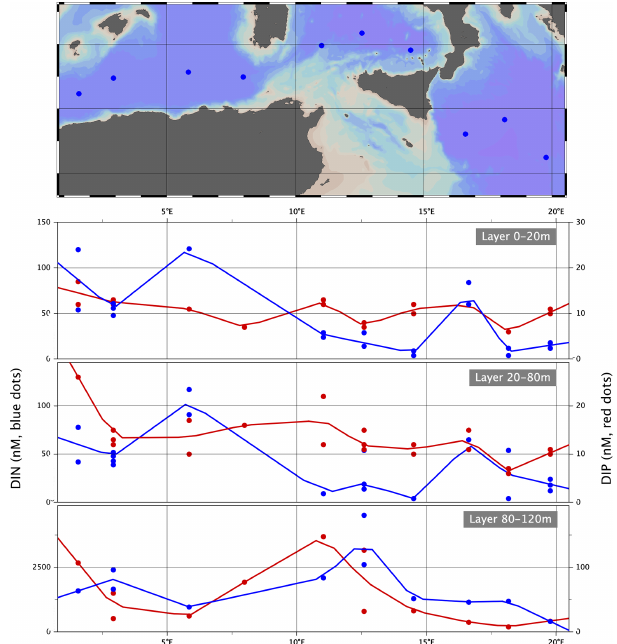
Figure 9. Nitrate (blue dots) and phosphate (red dots; Pulido- Villena et al., 2020) concentrations (nM) in three layers above 120m, during the PEACETIME cruise along the west–east gradi- ent shown on the